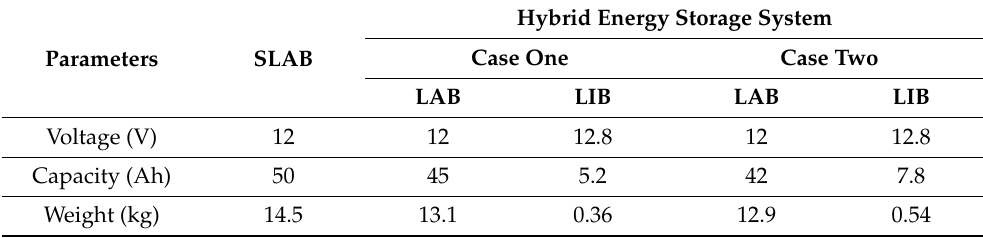
Table 6. Parameters of a single LAB 12 V–50 Ah and the battery parameters of the proposed HESS.